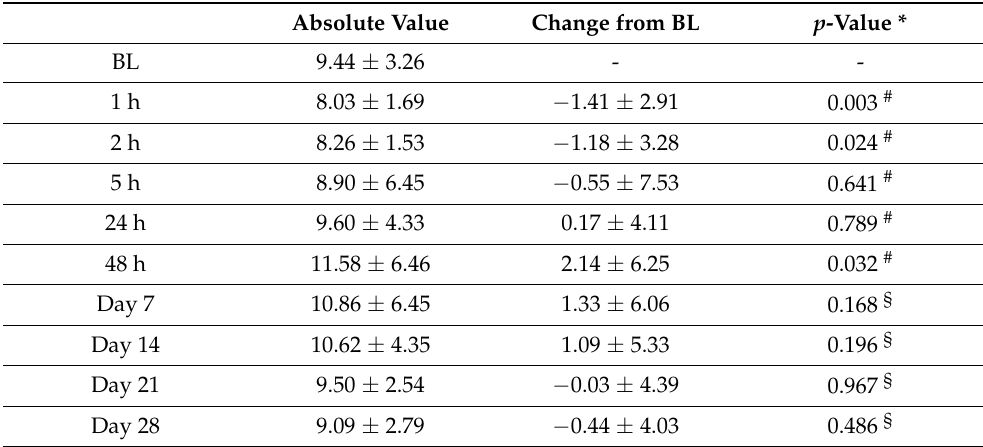
Table 8. Absolute TEWL measurement values and changes from baseline after single application of Emollient 3 (first 48 h) followed by once-daily application for 26